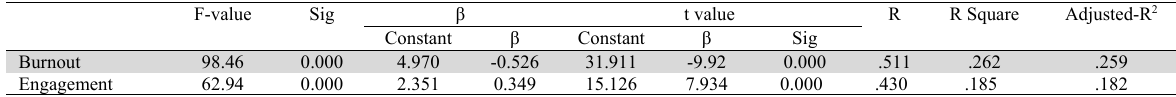
Regression results for major satisfaction